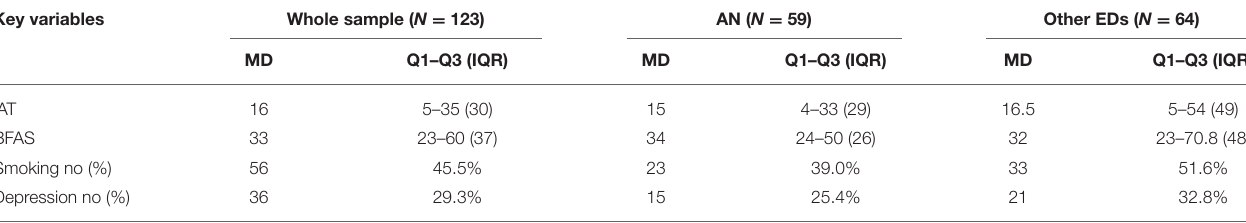
TABLE 2 | Descriptive statistics of internet addiction, Facebook addiction, smoking, and depression in the samples.